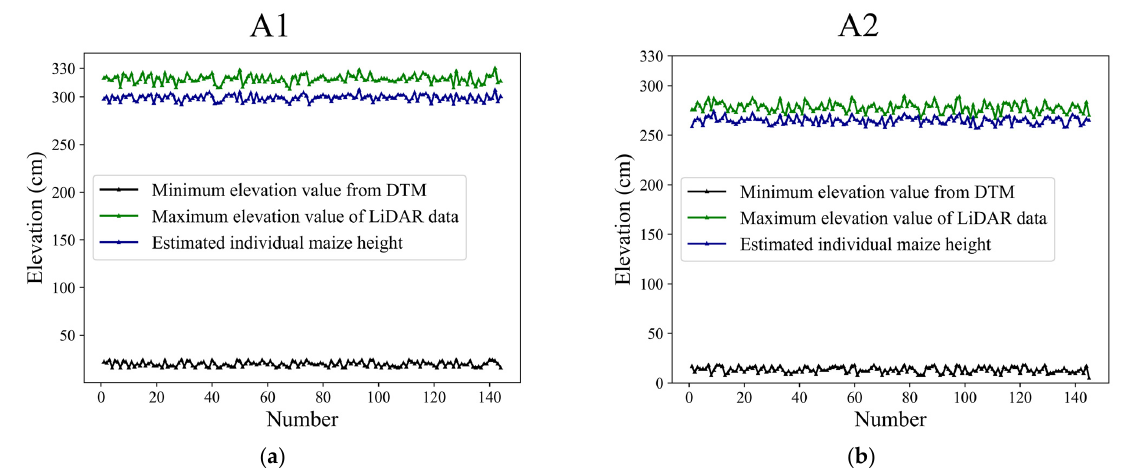
Figure 12. Segmentation of individual maize plants: ( a ) A1, ( b ) A2.